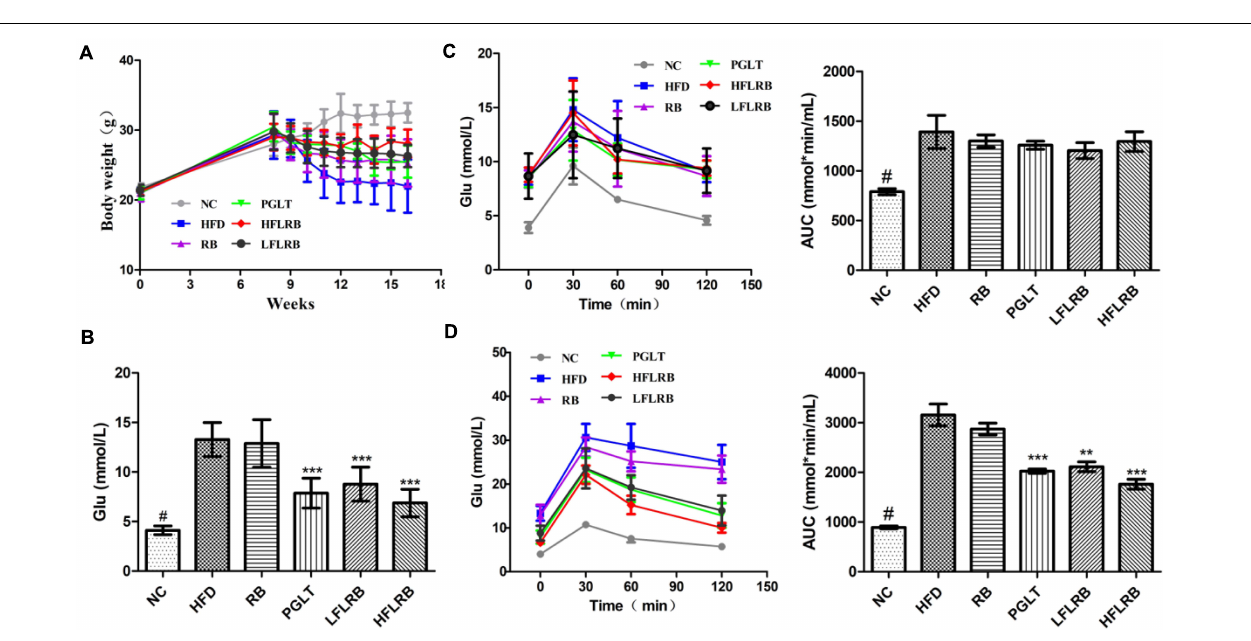
Frontiers in Microbiology |